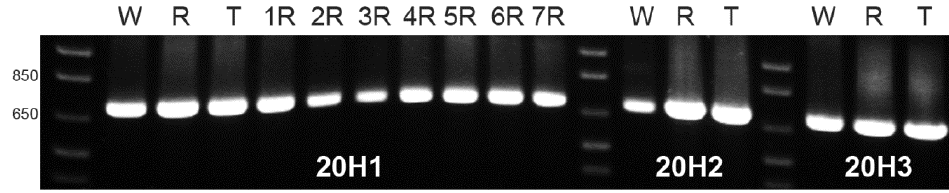
Figure 3. PCR banding profiles of wheat (W), rye (R), triticale (T) and seven wheat-rye addition lines (numbers correspond to rye homologous chromosomes pair) obtained with primers designed to amplify the three internal segments of pSc20H: 20H1, 20H2 and 20H3. All the pSc20H internal primers amplified a band with the expected size and identical in wheat, rye and triticale. Segment 20H1 is also amplified in all wheat-rye addition lines. Molecular weight marker: 1 Kb Plus DNA